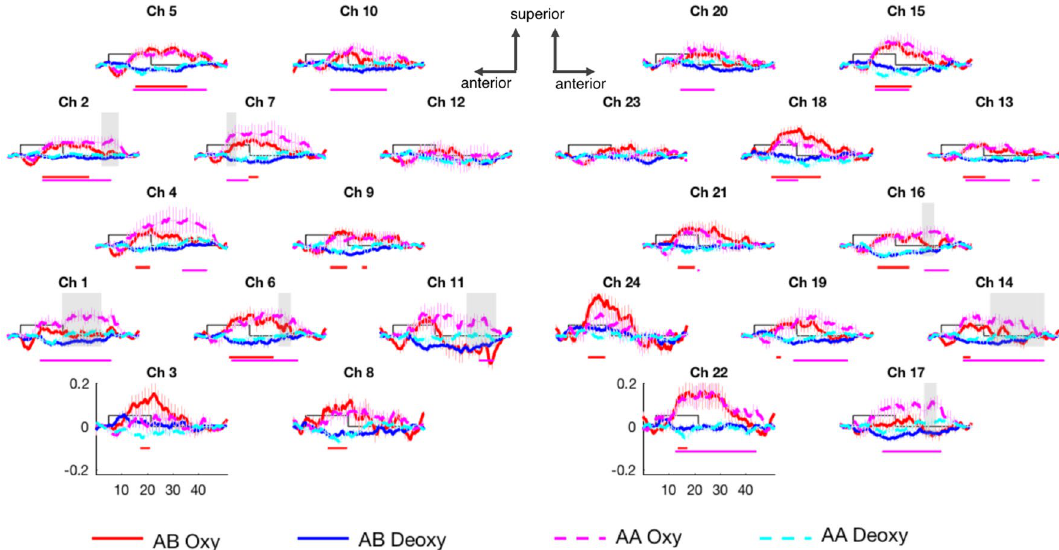
Figure 2. The grand average hemodynamic responses obtained in Experiment 1. Channels are plotted following the same placement shown in Fig. 1B. The x-axis represents time in seconds, the y-axis shows concentration in mmol*mm. The rectangle along the x-axis indicates time of stimulation in seconds. Continuous red and blue curves represent oxyHb and deoxyHb concentrations, respectively, in response to AB grammar. The dashed magenta and cyan curves represent oxyHb and deoxyHb concentrations, respectively, in response to AA signs. Lines placed below the plots indicate significant differences between the AB condition and baseline (red, top line) and the AA condition and baseline (magenta, lower line) as indicated by the permutation tests. For ease of exposition, only the time windows for oxyHb are shown. The results of the permutation tests for the direct comparison of the AA and AB conditions are indicated by gray-shaded rectangles overlaid on the curves. Error bars indicate standard errors of the means for every 20th data point in each